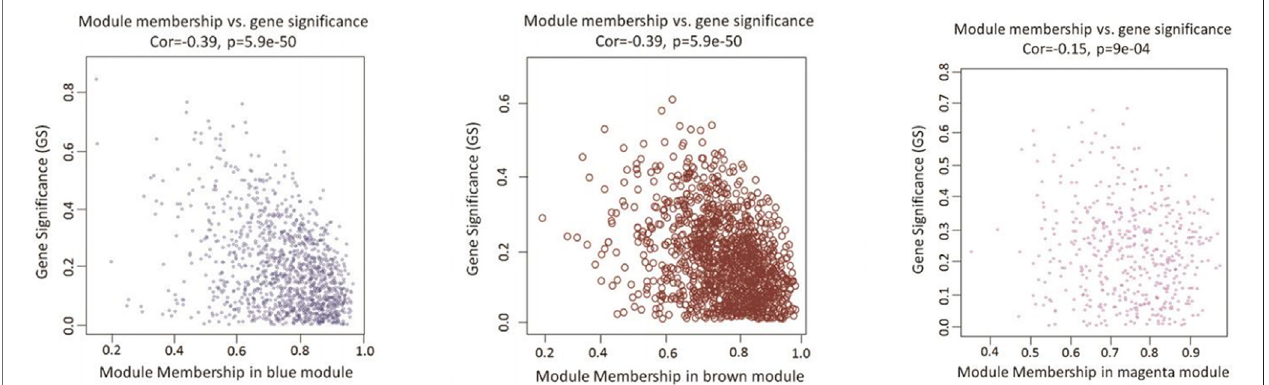
FIGURE4| ScatterplotsofGSvs.MMincandidatemodules.The fi gureshowstheGSinthethreesigni fi cantmodulescorrelatedwithadipocytedifferentiation.The x-axis represents the value of membership in each module, and the y-axis represents the GS of the genes in the blue, brown, and magenta modules. The gene in the lower right corner of each graph is the hub gene that is of interest to us. These genes are highly correlated with phenotypes and have a high MM, which is a good representation of the gene module.